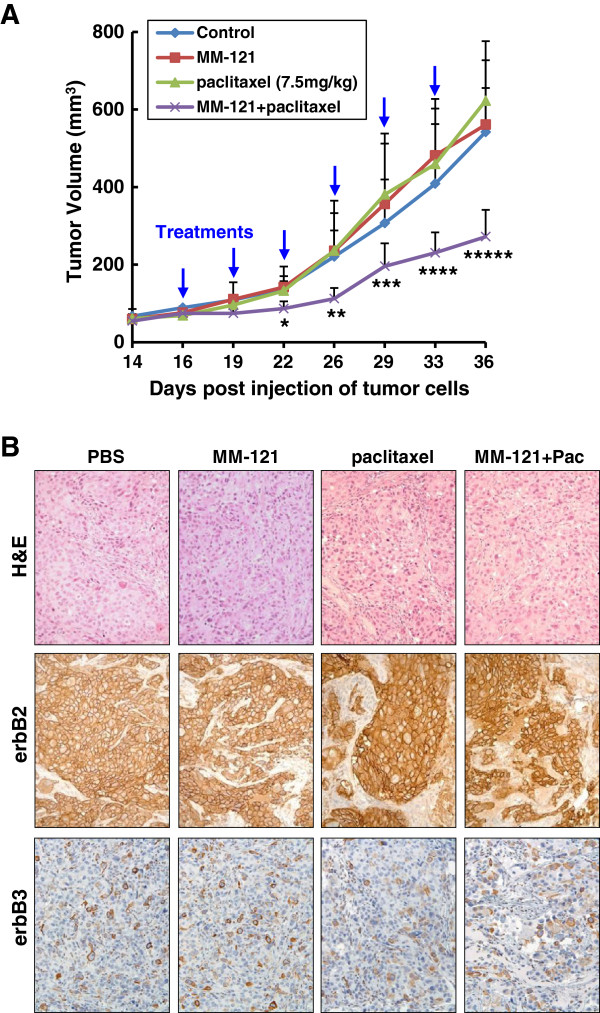
MM-121 in combination with low-dose paclitaxel significantly inhibits in vivo tumor growth of trastuzumab-resistant breast cancer cells in a murine model. BT474-HR20 cells were subcutaneously injected into nude mice to establish tumor xenografts. The tumor-bearing mice (n = 5) received intraperitoneal injections of either PBS, or MM-121 (10 mg/kg), or paclitaxel (7.5 mg/kg) alone, or both MM-121 and paclitaxel as described in Methods. After six treatments the mice were euthanized at day 36 post injection of tumor cells, and all tumors were excised for histology and IHC analysis. (A) The graphs show the tumor growth curves. Bars represent SD. *P <0.04 versus control or MM-121; **P <0.05 versus MM-121 and P <0.005 versus paclitaxel; ***P <0.04 versus paclitaxel; ****P <0.05 versus control, P <0.008 versus MM-121, and P <0.02 versus paclitaxel; *****P = 0.005 versus control, P <0.004 versus MM-121, and P = 0.0006 versus paclitaxel. (B) Data show the representative tumors with H&E staining and IHC analysis of erbB2 and erbB3 receptors.